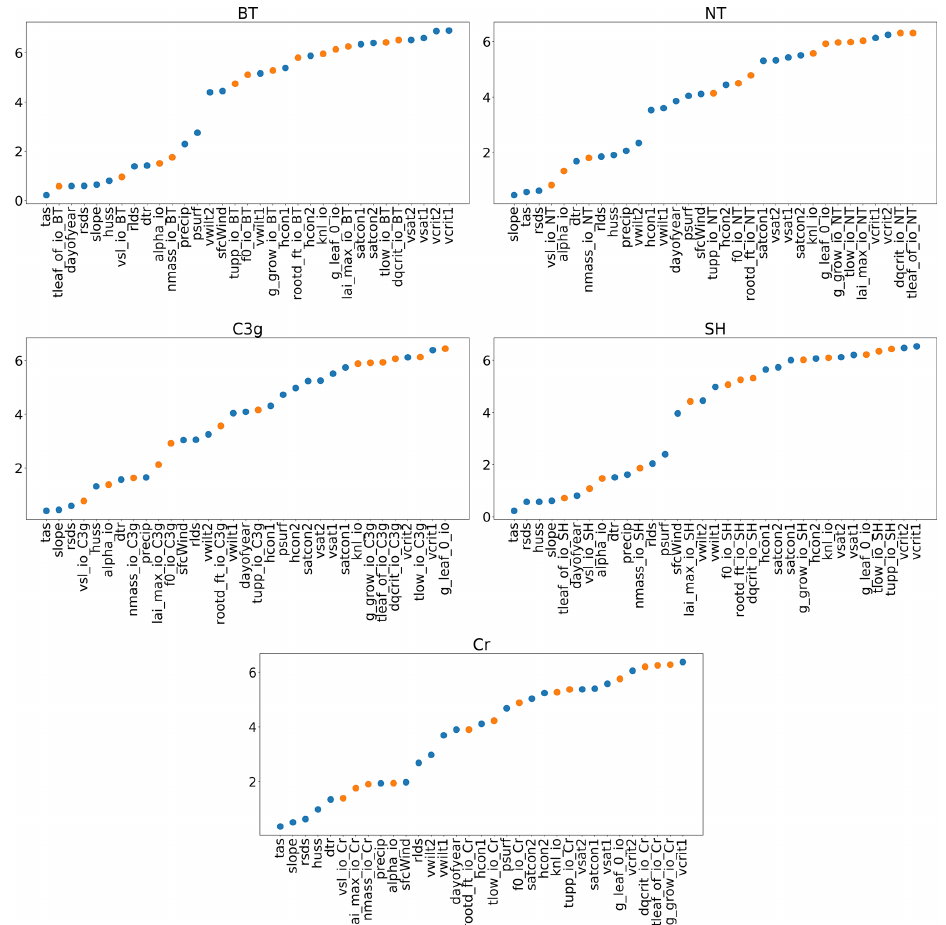
Figure 3. Estimated length scales from the Gaussian process emulators; a smaller value implies a stronger relationship between the input and GPP. Orange points represent tuning parameters and blue dots represent environmental data. Descriptions for the tuning parameter abbreviations can be found in Table 1, and descriptions for the environmental data can be found in Table